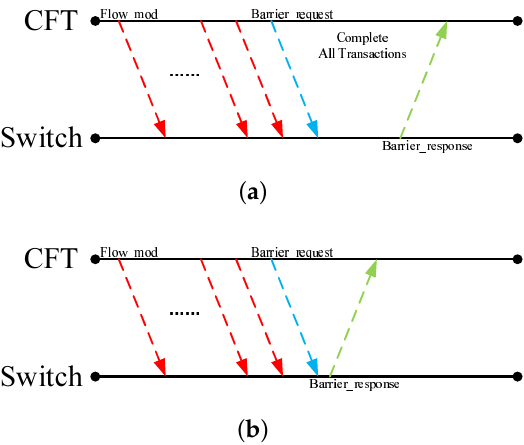
Figure 11. The different implementations of the Barrier message; ( a ) the correct implementation of the Barrier message, ( b ) the incorrect implementation of the Barrier